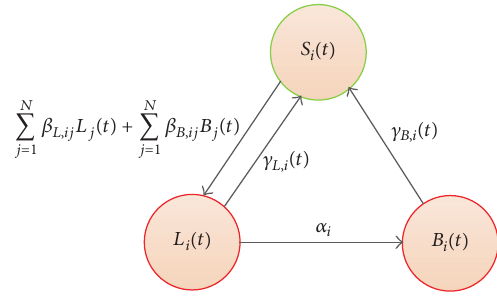
Figure 1: Diagram of assumptions ( H 1 ) – ( H 5 )